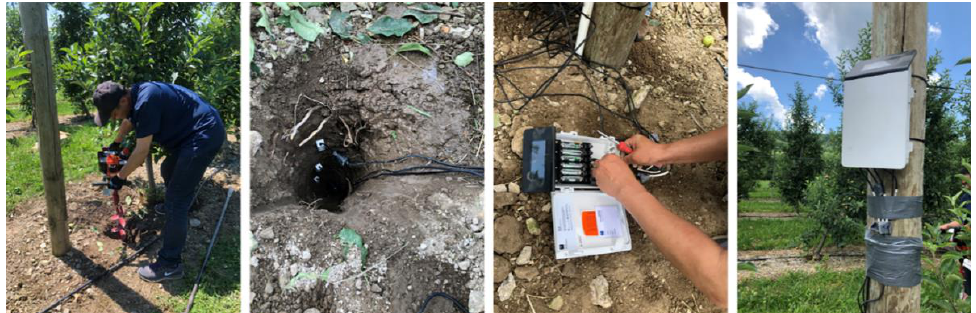
Figure 3. Soil moisture sensor systems setup in the orchard. From left to right: drill a hole for sensors, install sensors at different depths, connect sensors to a datalogger, place the datalogger to a pole.